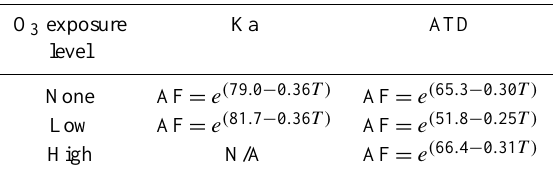
Table 3. Fits for deposition mode ice-active fraction as a function of temperature ( T ) at RH w = 95% as shown in Fig. 7. O 3 exposure Ka